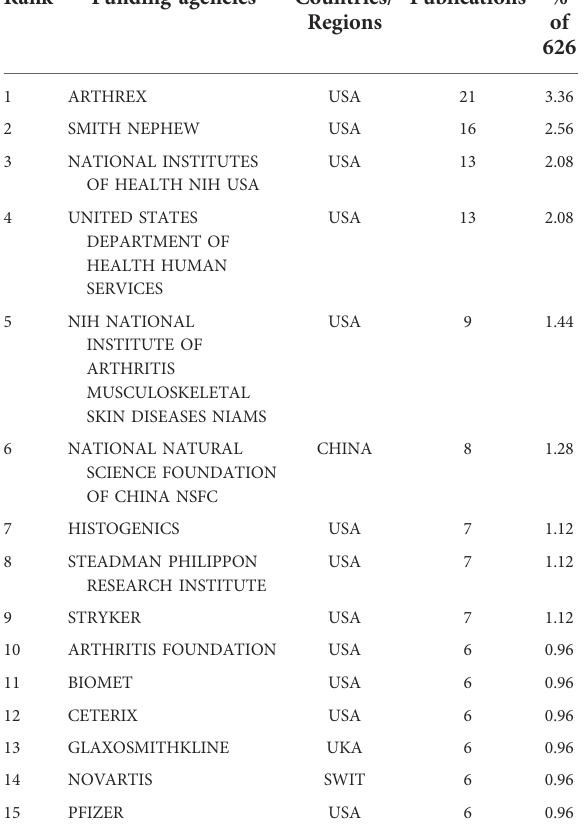
TABLE 3 The top 10 related funding